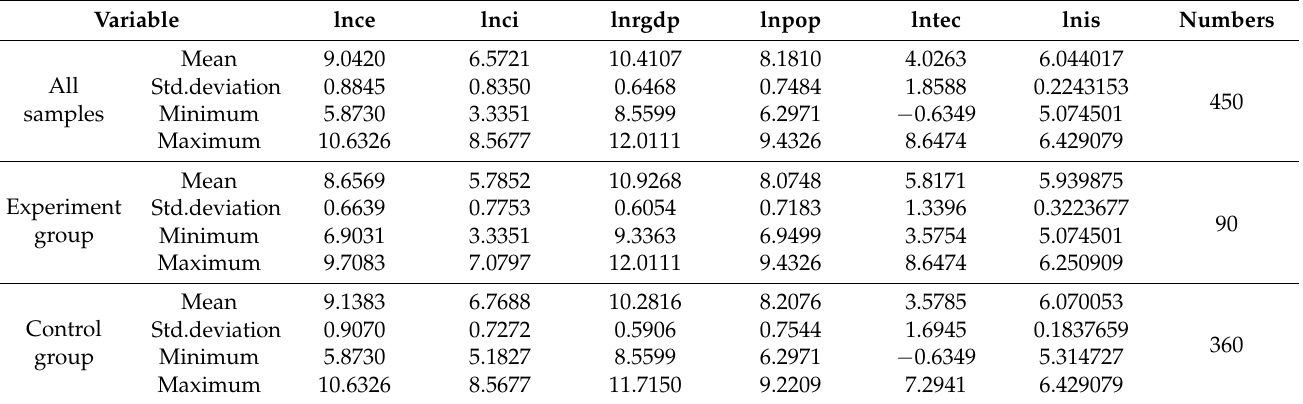
Table 2. Meaning and descriptive statistics of each